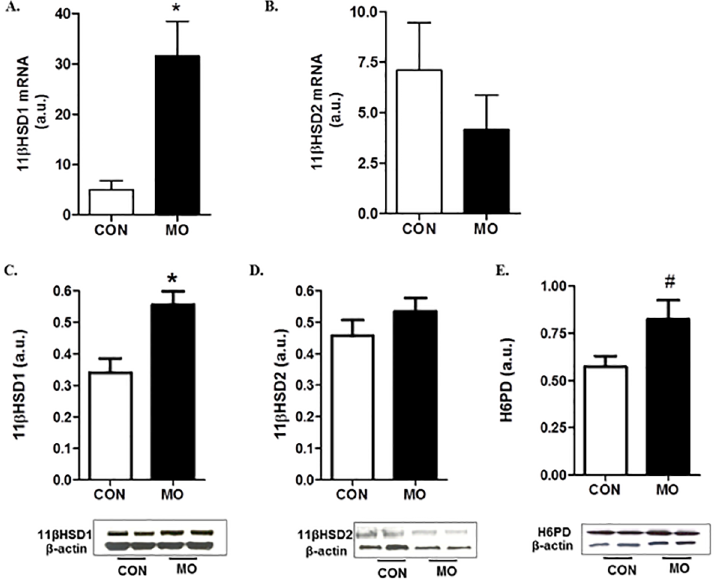
Fig 2. Gene and protein expressionof 11 β HSD1(A,C), 11 β HSD2(B,D) and protein expression of H6PD (E) in the livers of CON (open bars, n = 6) and MO (solid bars; n = 6) adult male F1 offspring. # Means ± SEM tendedto differ, ( P < 0.06). * Means ± SEM differ, ( P <